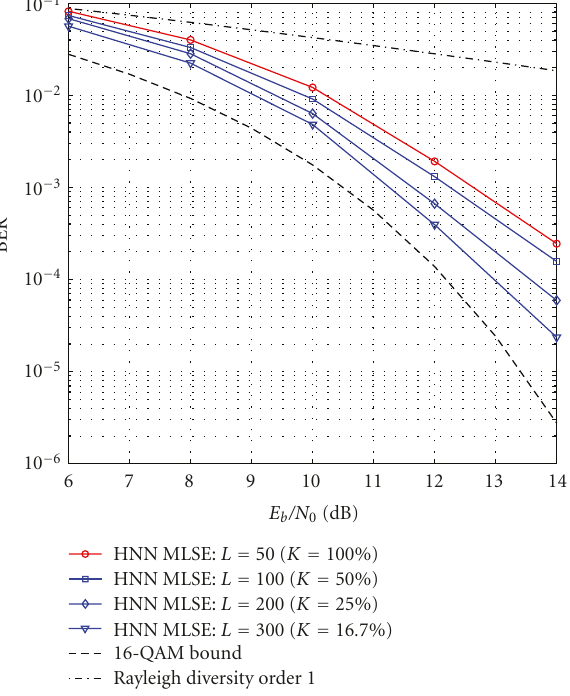
Figure 18: 16-QAM HNN MLSE equalizer performance in sparse channels.